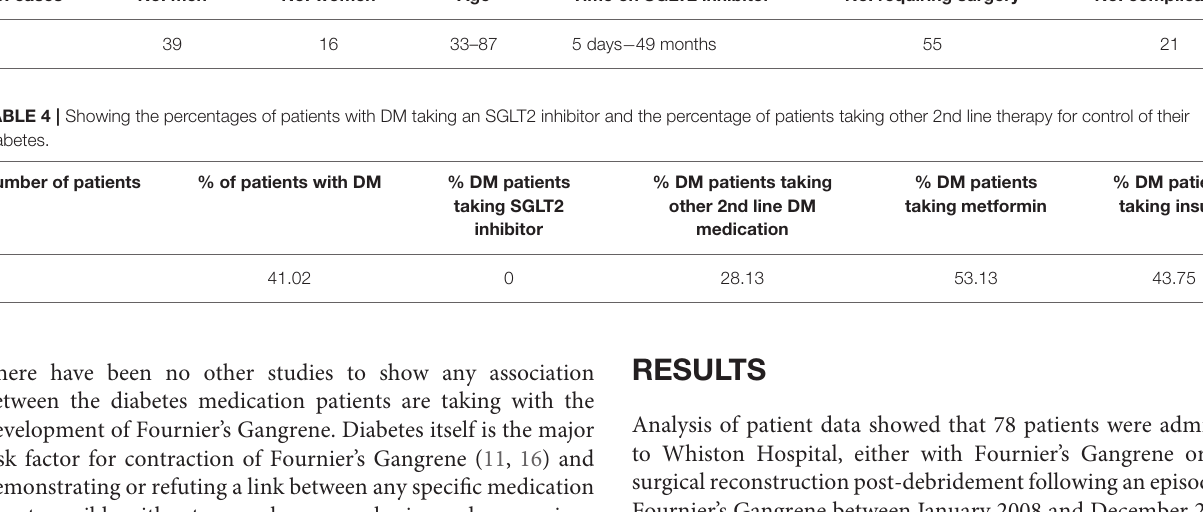
TABLE 3 | Results of a descriptive case series carried out by the FDA in June 2019 after the initially published warning in February 2019 (25). No. cases